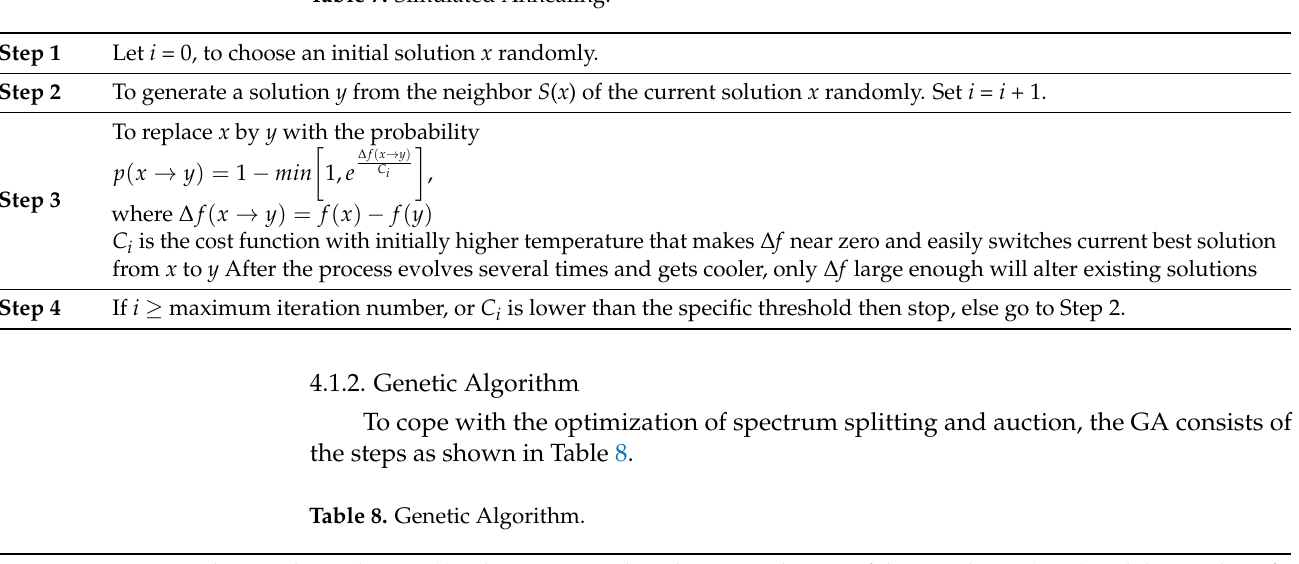
Table 7. Simulated Annealing.